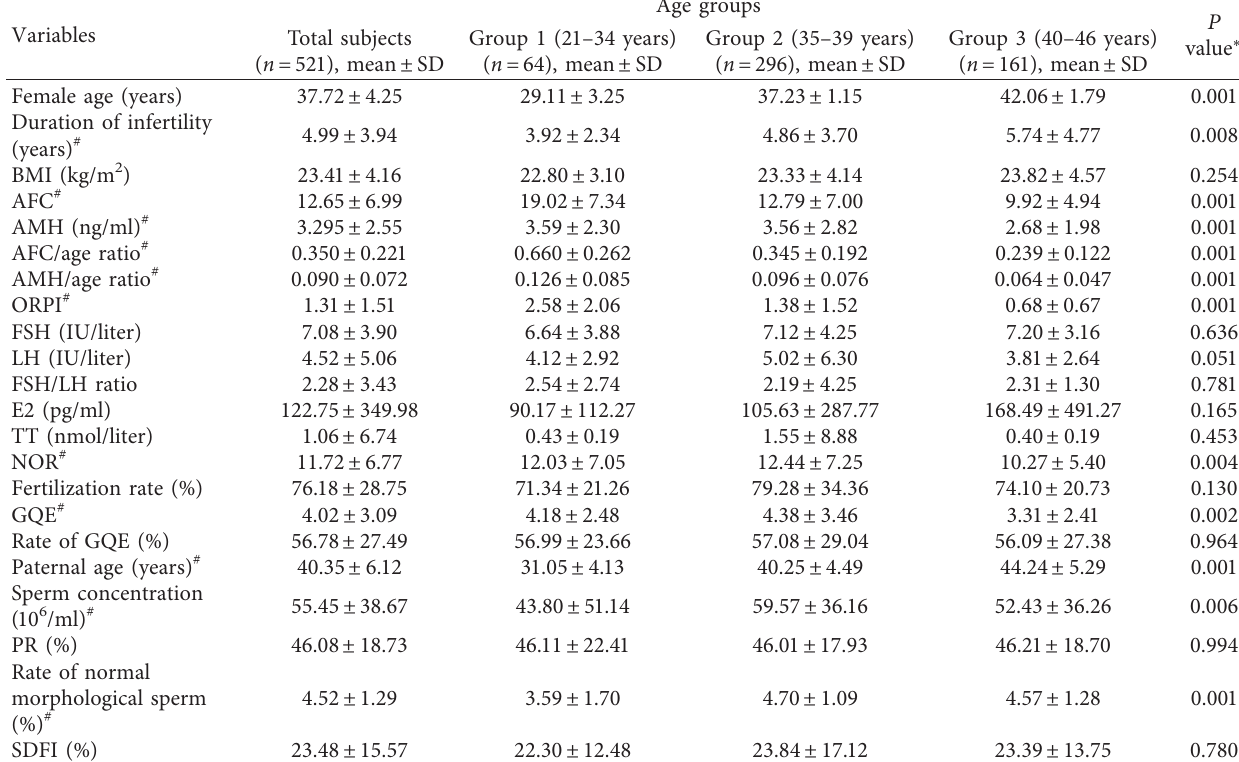
Table 1: Clinical data and variables’ data of different age